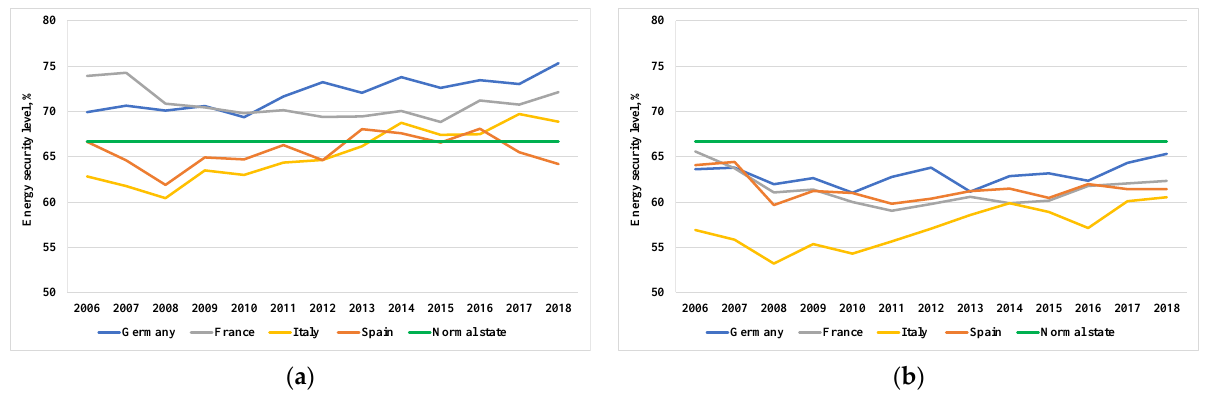
Figure 5. The electricity and natural gas security level in analyzed countries: ( a ) electricity, and ( b ) natural gas. Source: own research.